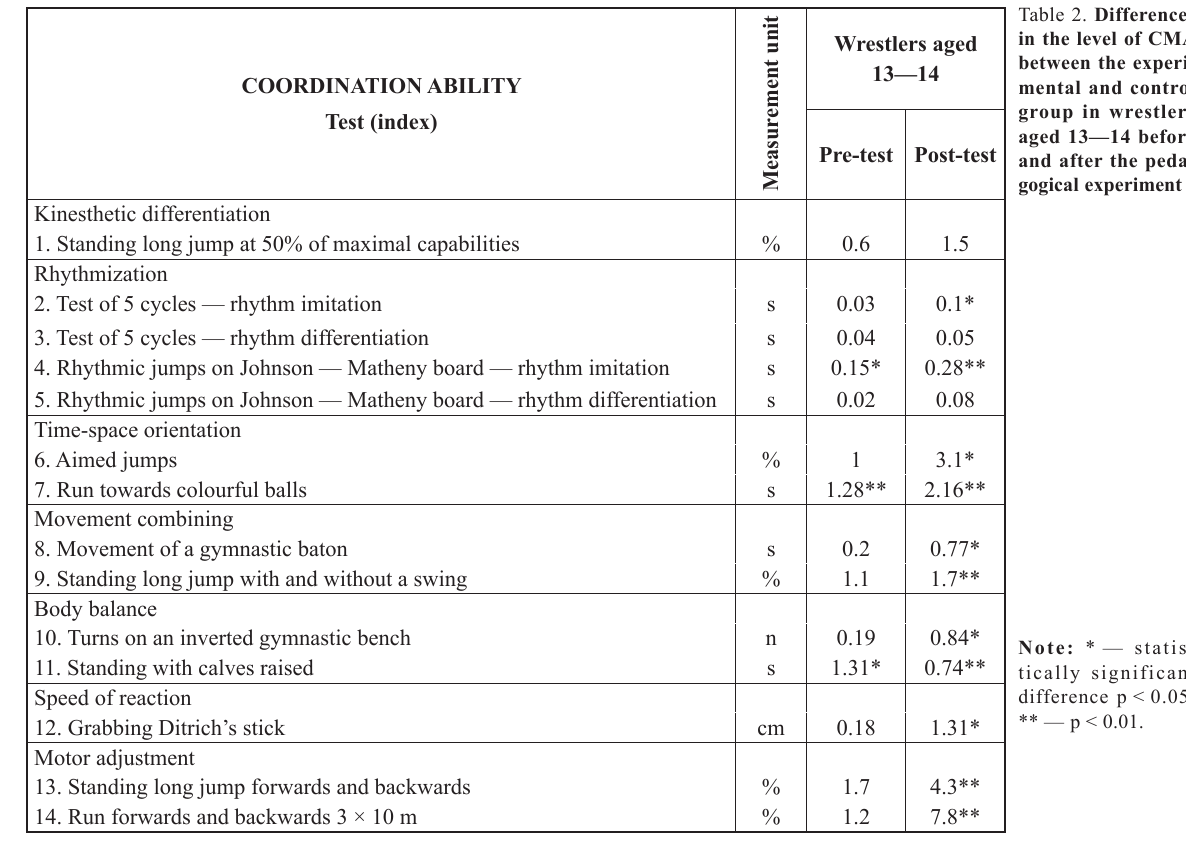
Table 2. Differences in the level of CMA between the experi- mental and control group in wrestlers aged 13—14